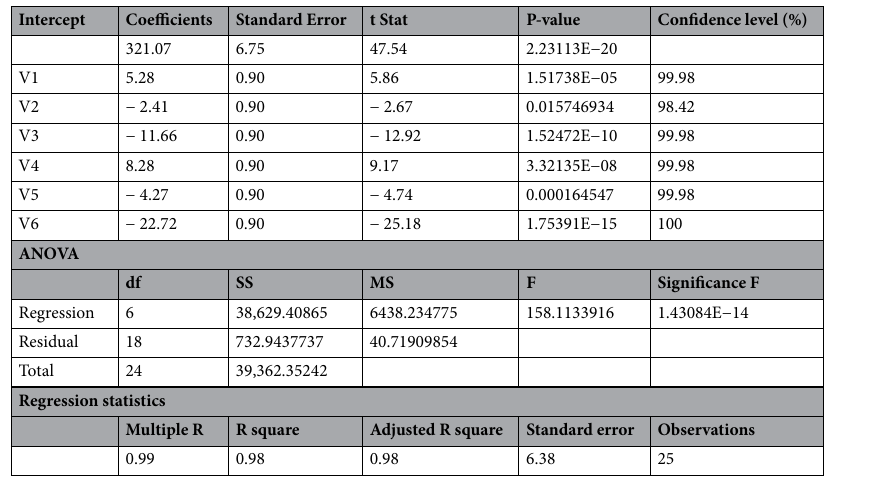
Table 8. Regression statistics and analysis of variance (ANOVA) for Taguchi experimental